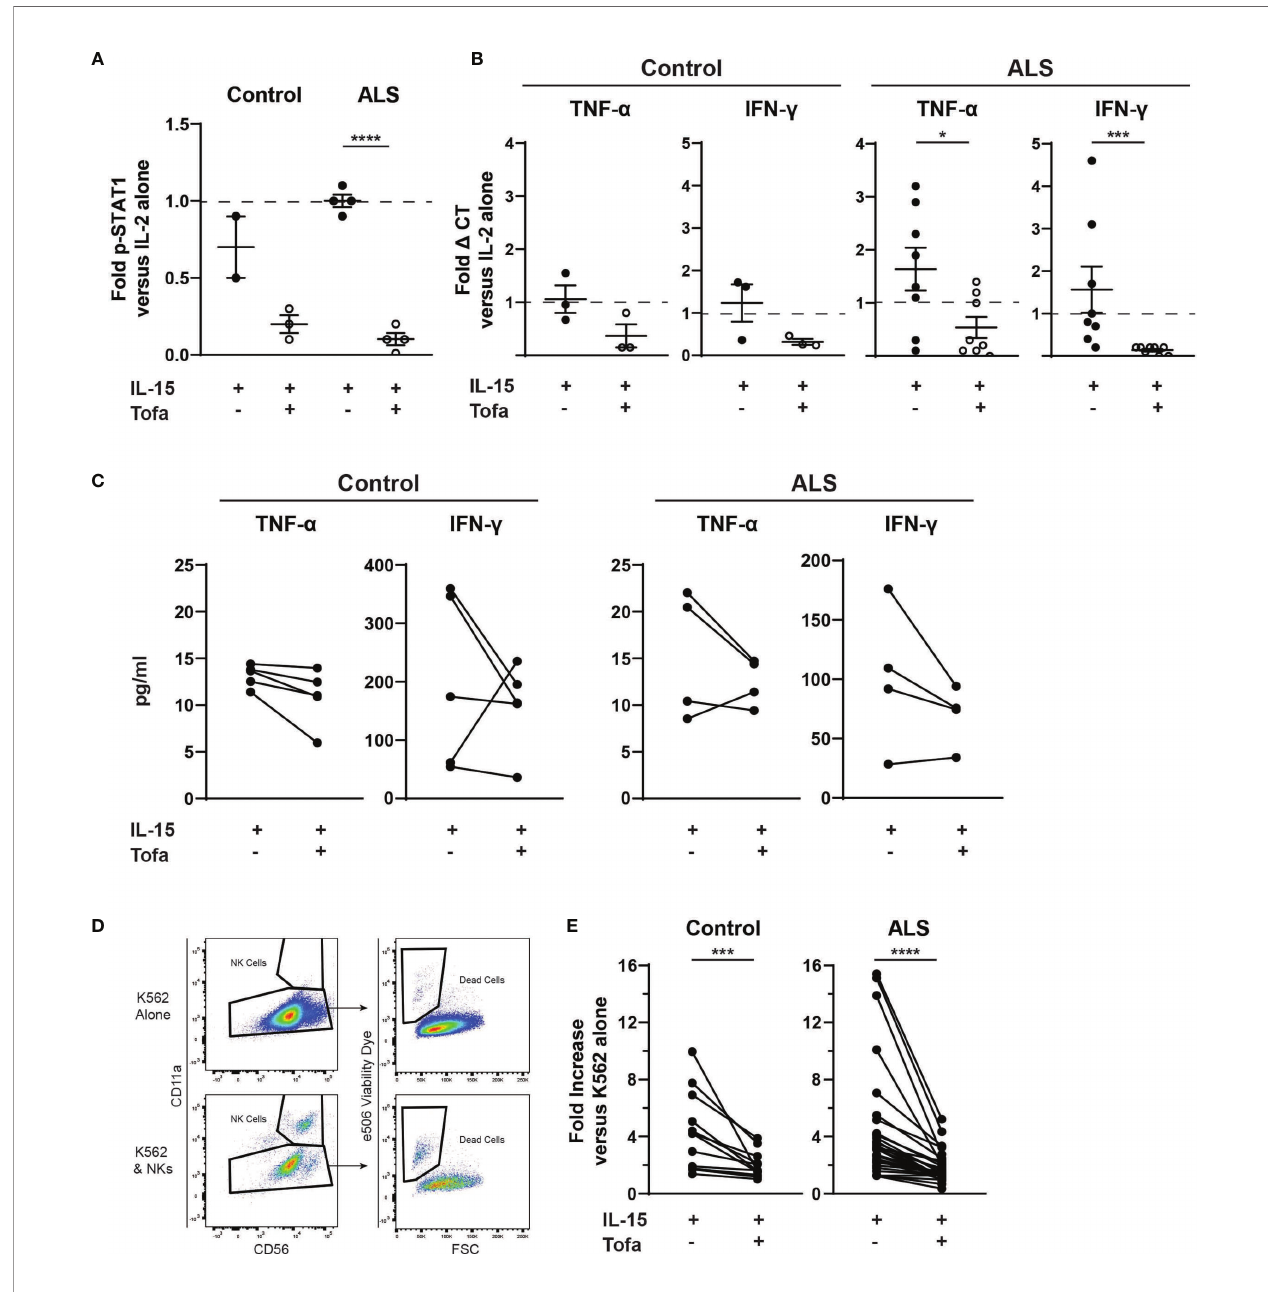
FIGURE 3 | Tofacitinib inhibits primary NK cells in vitro . Primary NK cells were enriched from the whole blood of control and ALS participants. (A) P-STAT1 was assessed using Western blot. Primary NK cells were incubated with IL-2 alone, IL-2 + IL-15, or IL-2 + IL-15 + tofacitinib for 2 hours. Protein extracts were resolved by SDS-PAGE and immunoblotted for total STAT1, phosphorylated STAT1 (P-STAT1), and a -tubulin (internal reference). Graph represents densitometric analysis where total STAT1 and P-STAT1 signals were normalized to a -tubulin then normalized to NK cells receiving IL-2 alone; n = 2-4 participants. (B) Cytokine gene expression was assessed using qRT-PCR for TNF- a and IFN g . Data were normalized to yWHAZ expression and normalized to the IL-2 NK cells; n = 3-8 participants. (C) Extracellular expression of TNF- a and IFN- g was assessed for primary NK cells cultured with IL-15 ± tofacitinib (n = 5 control and n = 4 ALS). (D) Primary NK cells were assessed for cytotoxicity. Primary NK cells were cultured for two hours with K-562 cancer cells (1:1 ratio) + IL-15 ± tofacitinib; K-562 cell death was assessed using fl ow cytometry to quantitate e506 viability dye fl uorescence. (E) Data were quantitated by normalizing to K-562 cells cultured without NK cells; n = 12 control and n = 32 ALS. For (A, B) , data are presented as mean ± SEM with dashed line showing cells cultures with IL-2 alone; comparisons were made by Student ’ s t-test. For (C) , comparisons were made using a paired t-test. For (E) , comparisons were made by Wilcoxon test to assessed paired, non-normally distributed data. * P < 0.05, *** P < 0.001, **** P <